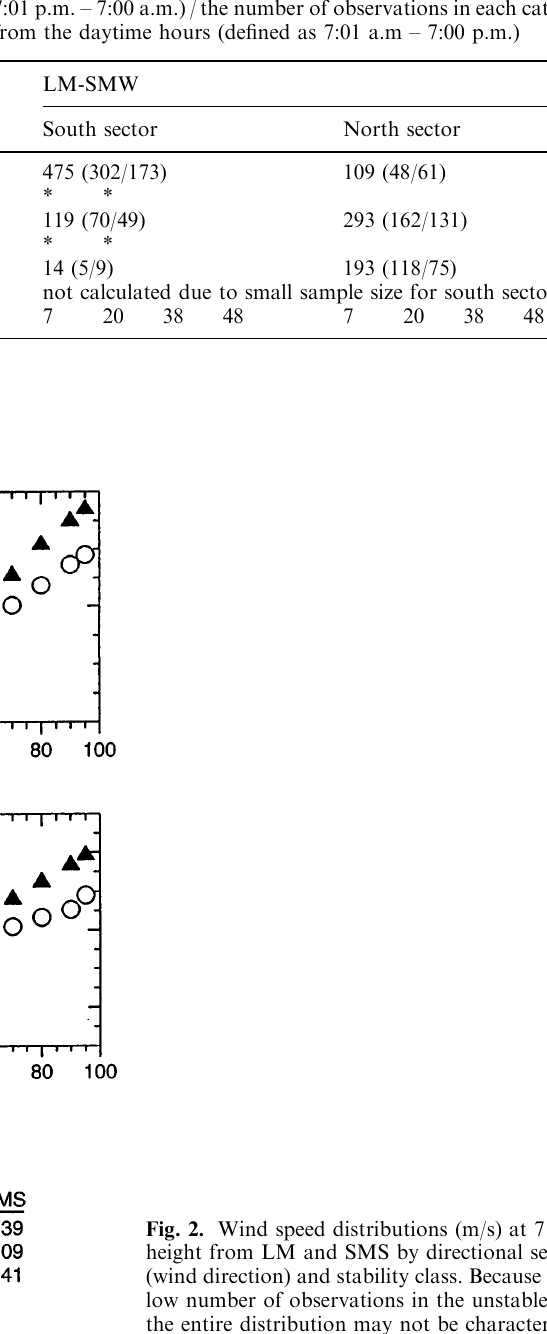
the total counts indicate the number of observations in each stability - direction category from the nighttime hours/(defined as